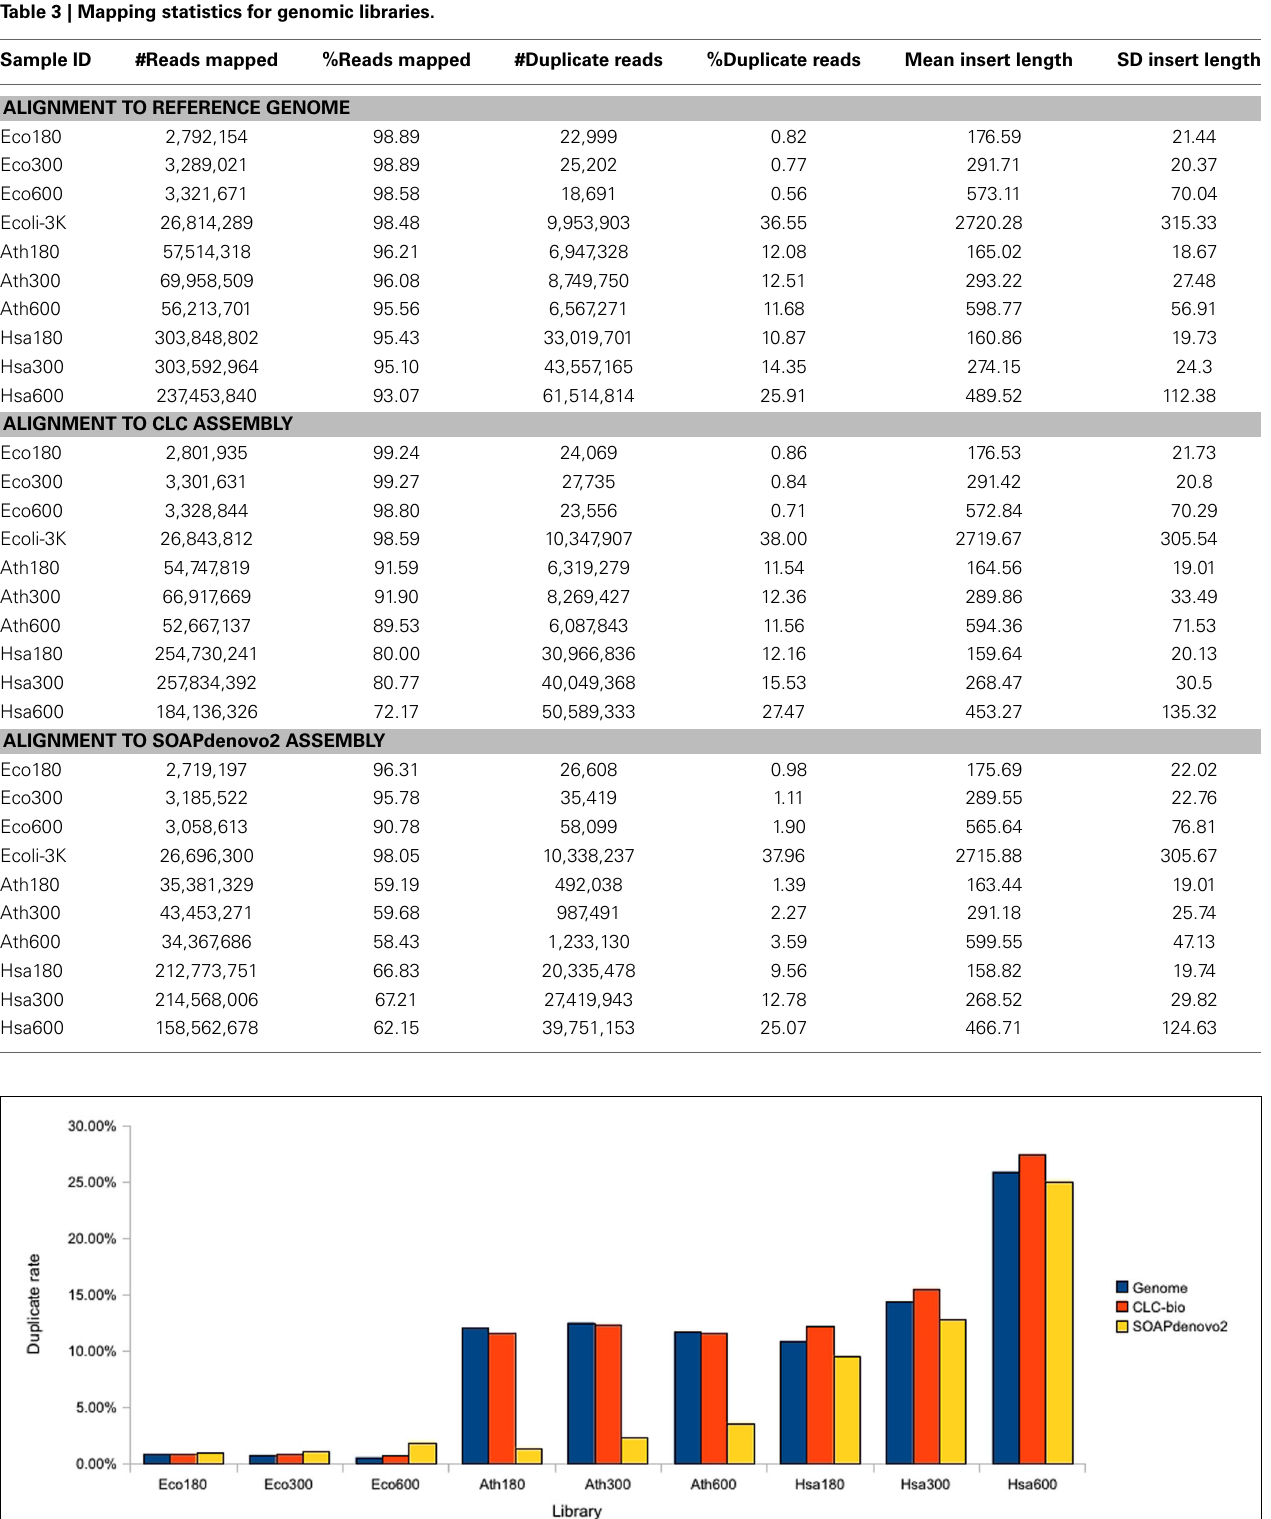
FIGURE 1 | Estimation of duplicate rate for paired-end genomic libraries. Duplicate rates are plotted for each species and each target size using reads mapped against the species reference, CLC, and SOAPdenovo2